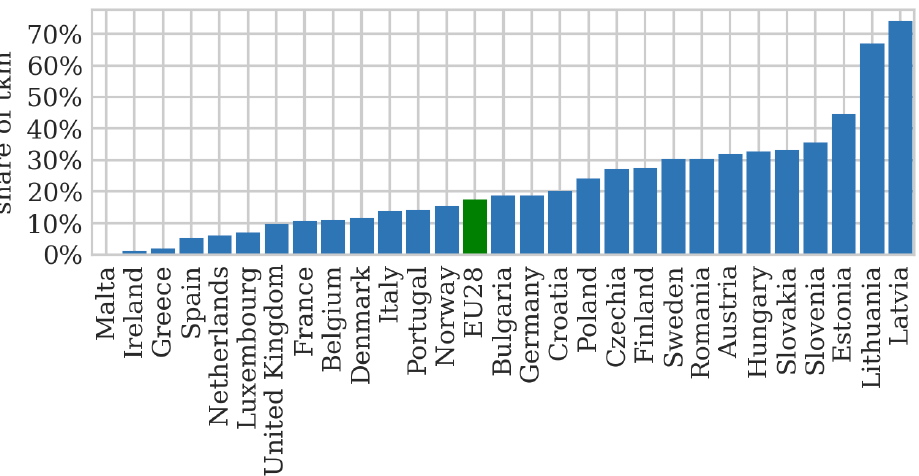
Figure 7. Modal share of railway transportation in freight transport for selected European countries in 2017. Own study based on data from